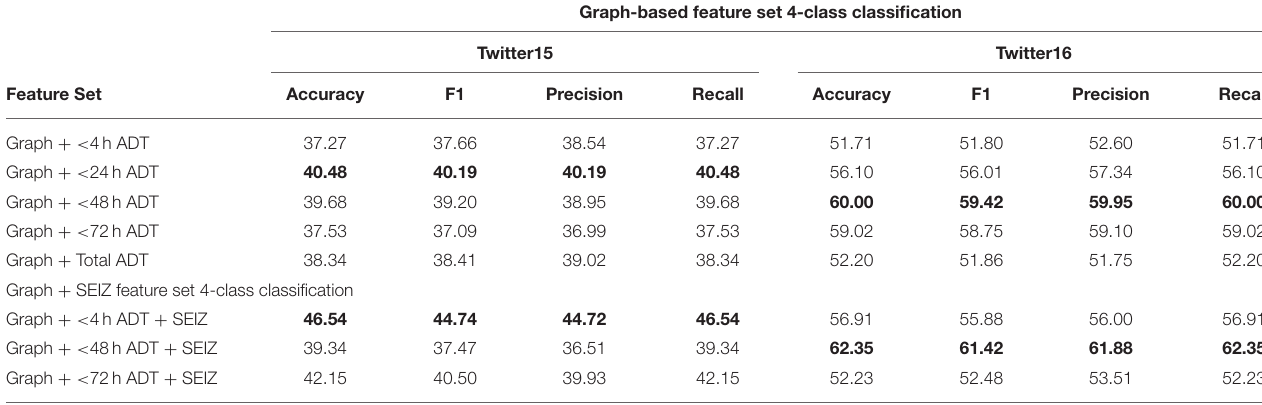
TABLE 7 | Twitter15 and 16 Graph-based and combined feature sets − 4-class classification results.